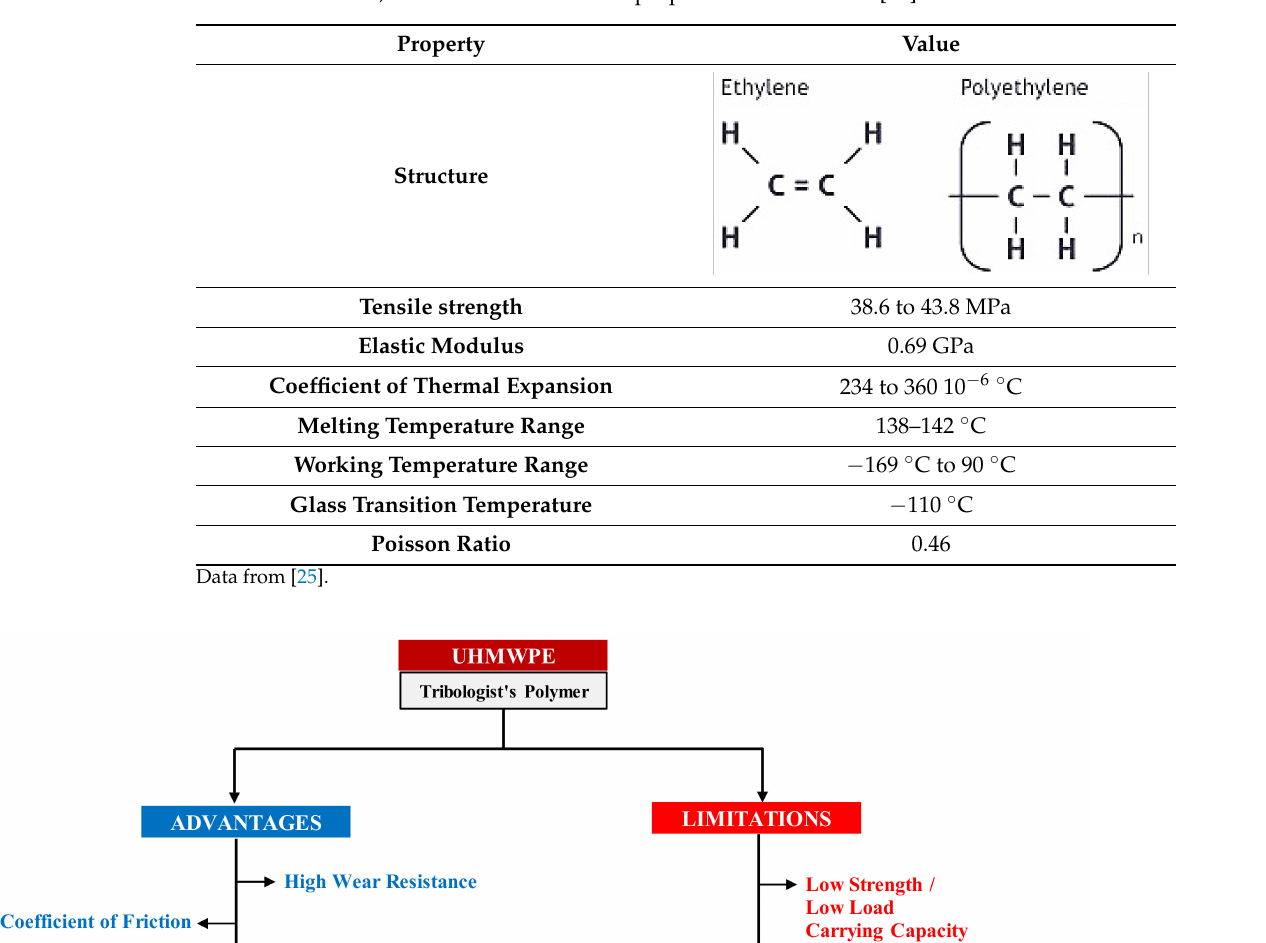
Table 1. Structural, mechanical and thermal properties of UHMWPE [25].